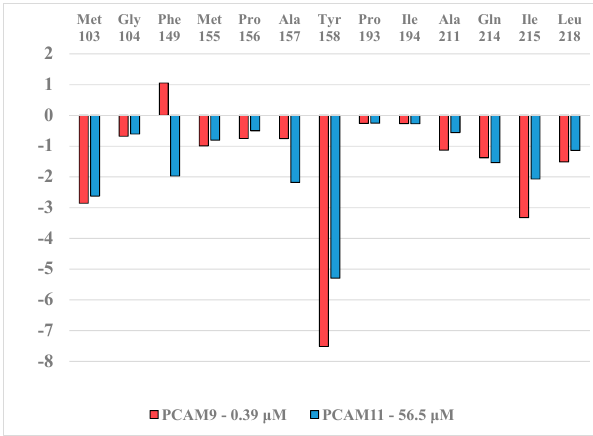
Figure 6. Molecular mechanics intermolecular interaction energy E int breakdown (in kcal·mol − 1 ) to residue contributions for PCAM9 and PCAM11, Table 2 [12].